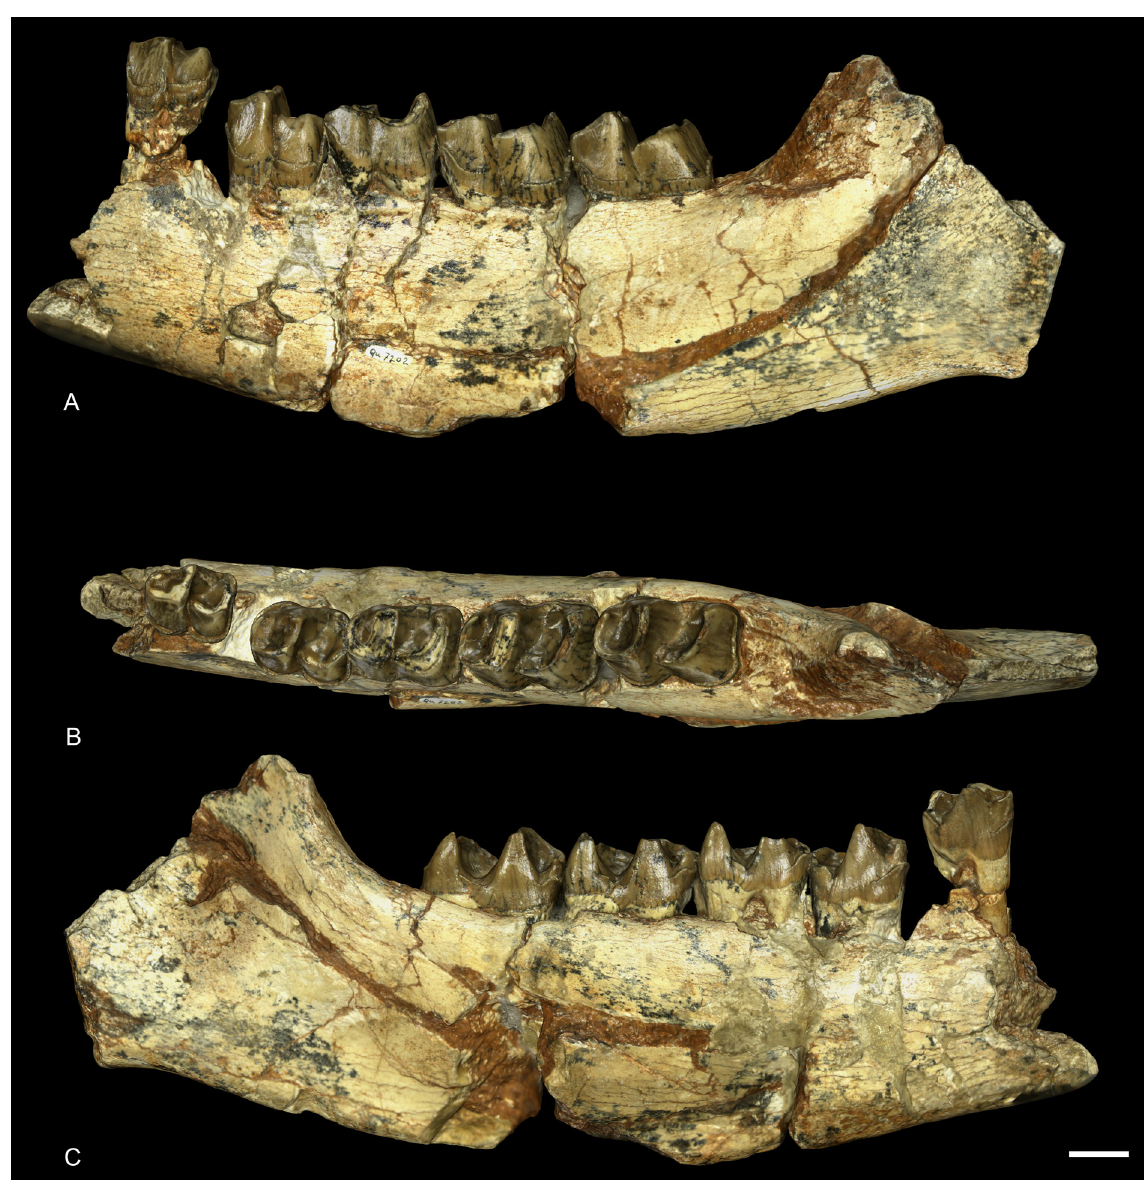
Fig. 12. Ronzotherium filholi (Osborn, 1900) from the Phosphorites du Quercy (early Oligocene?, France). Paratype left hemimandible MNHN.F.QU7202 with p3–m3. A . Lateral view. B . Occlusal view. C . Medial view. Scale bar: 2